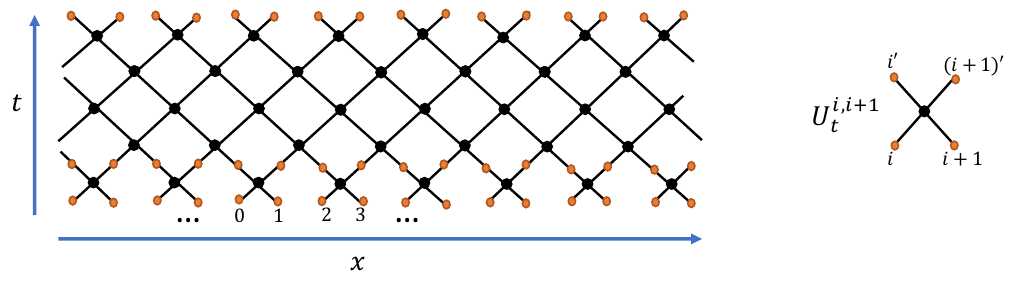
Figure 8 . Unitary circuit for the time-evolution operator U ( t ) (3.1)–(3.2) for t = 5 . The black circles represent unitary matrices U i,i +1 acting on two adjacent sites i and i + 1 . In the random t circuit model, U i,i +1